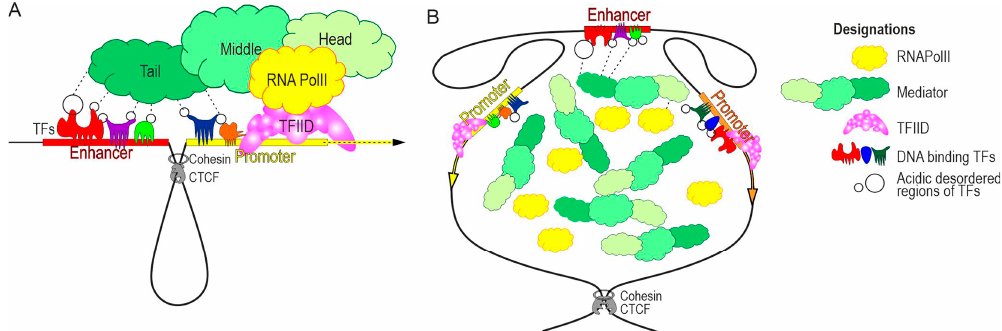
Figure 2. Models showing the remote activation of a promoter by an enhancer. ( A ) Classical model of enhancer-promoter communication. The interaction between an enhancer and a promoter can be stabilized by CCCTC-binding factor (CTCF), in cooperation with the cohesin complex and the dimerization of LOB domain-containing protein 1 (LDB1), which is recruited to chromatin through interactions with LIM proteins. The TFs bind to the enhancer and a promoter to form a platform for the transient recruitment of the mediator complex. The mediator complex transfers RNA polymerase II to the promoter transcription factor IID (TFIID) complex and accelerates further transcription initiation steps to induce a short transcriptional pulse (burst). The enhancer strength is directly correlated with the efficiency of mediator recruitment to chromatin. ( B ) Model of enhancer-promoter communication through the formation of hubs. Interactions between CTCF/cohesion sites form domains in which enhancers and promoters are located relatively close to each other. TF activation domains associated with enhancers usually contain internally disordered regions that can efficiently interact with subunits of the Mediator and RNA polymerase II complexes. As a result, the concentration of transcriptional complexes increases near enhancers, and promoters can more efficiently recruit these complexes to initiate transcription.